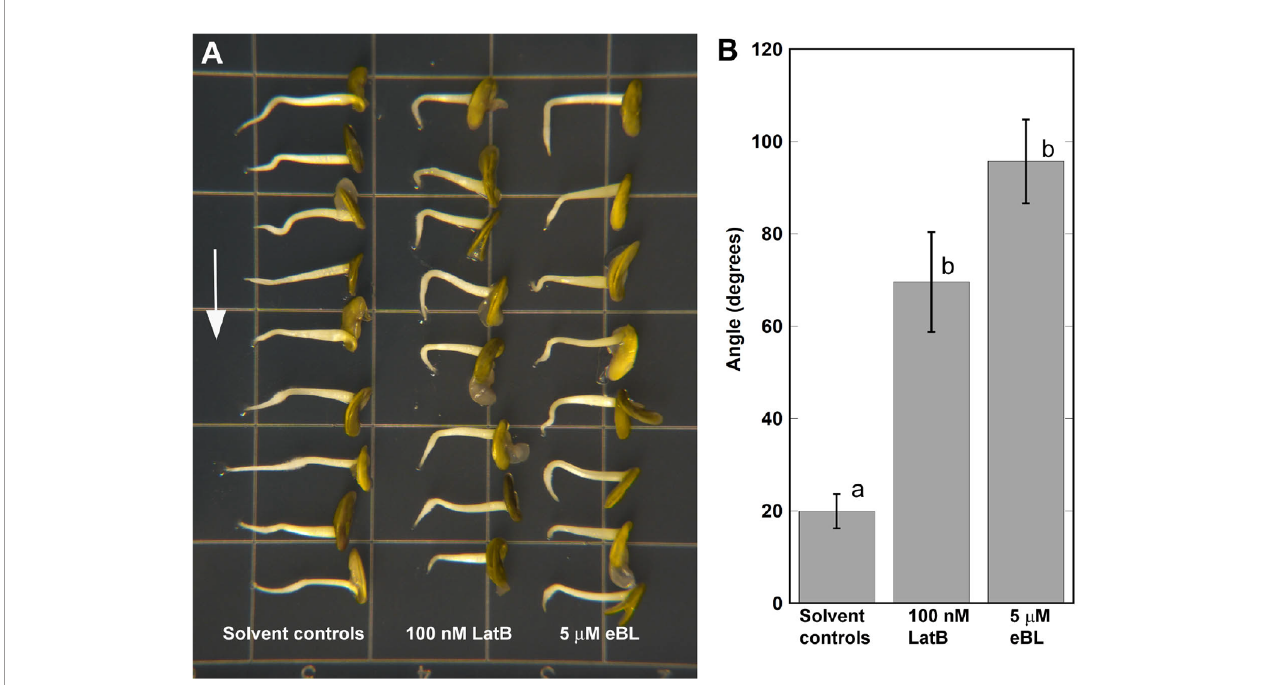
FIGURE 4 | Epi-Brassinolide (eBL)- and LatB- dampened straightening of M. truncatula roots expressing UBQ10:GFP-ABD2-GFP . (A) Representative images of M. truncatula roots grown on a 2-D clinostat for 15 h to test autotropic straightening after withdrawal of the gravity signal. Vertical roots treated with 100 nM LatB and 5 m M eBL for 1 h were mounted on a 2-D clinostat and kept horizontal for 20 min prior to clinorotation. (B) Quanti fi cation of angle of curvature after 15 h of clinorotation. Statistical signi fi cance was determined by one-way ANOVA. Means (n > 14 roots) ± S.E. Different letters indicate signi fi cant differences among means (P < 0.05, Tukey ’ s